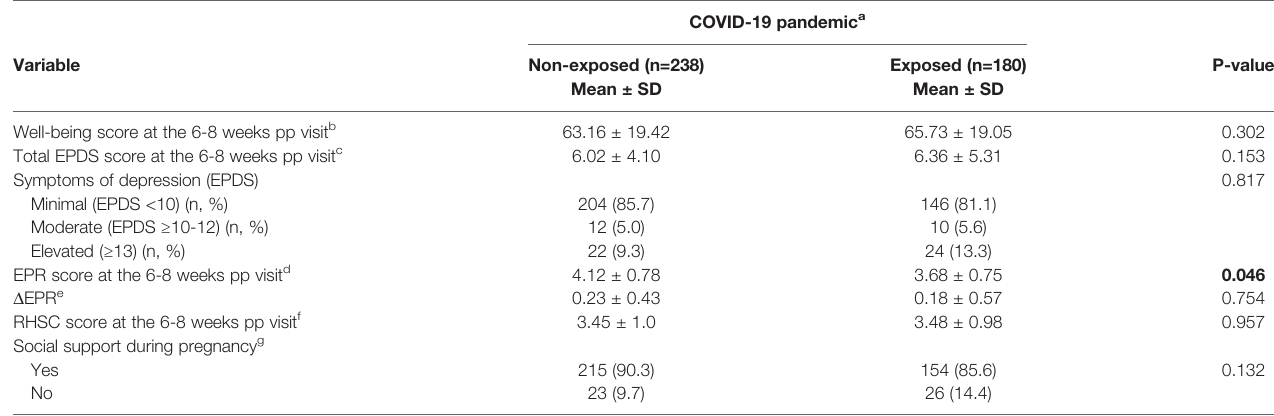
TABLE 3 | Maternal mental health outcomes in the postpartum a year before and during the pandemic.